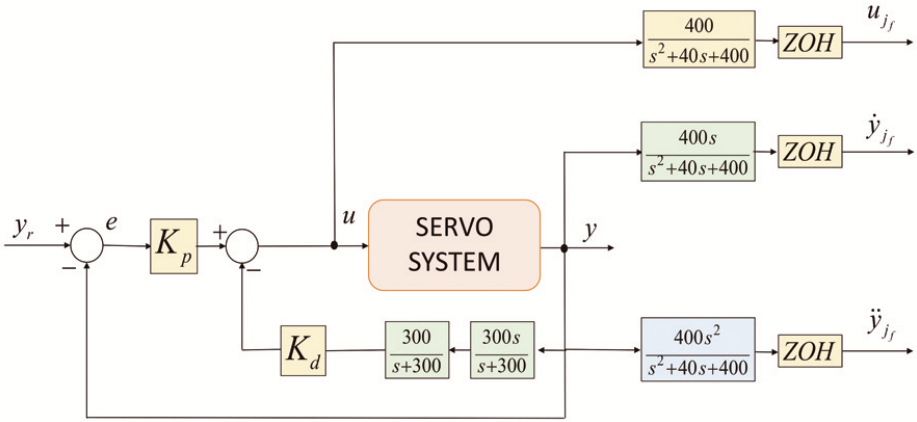
Figure 4. Servo system signal filtering block diagram.